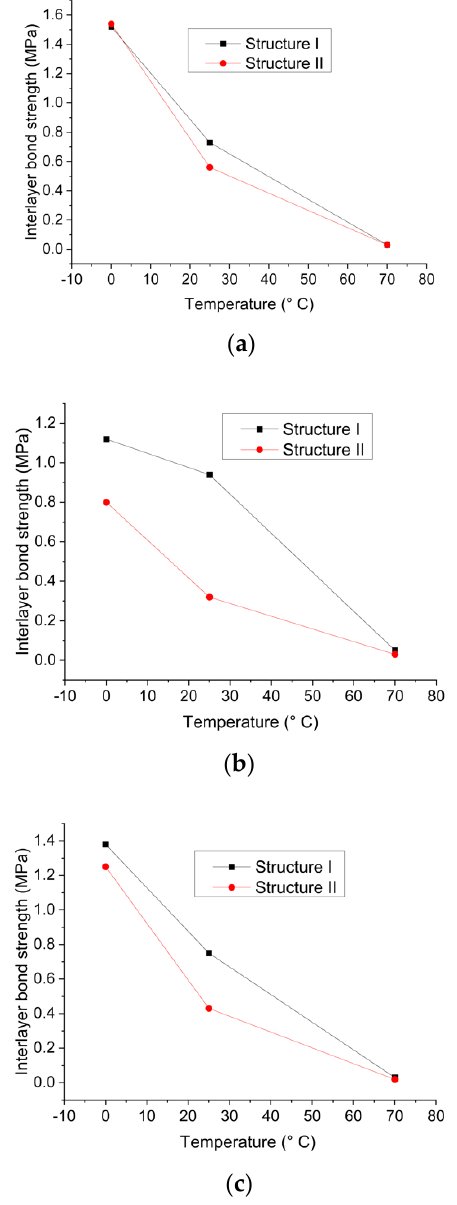
Figure 15. Interlayer shear strength of the same adhesive material in each structure: ( a ) Resin emulsified asphalt; ( b ) Modified emulsified asphalt; ( c ) Ordinary emulsified asphalt.